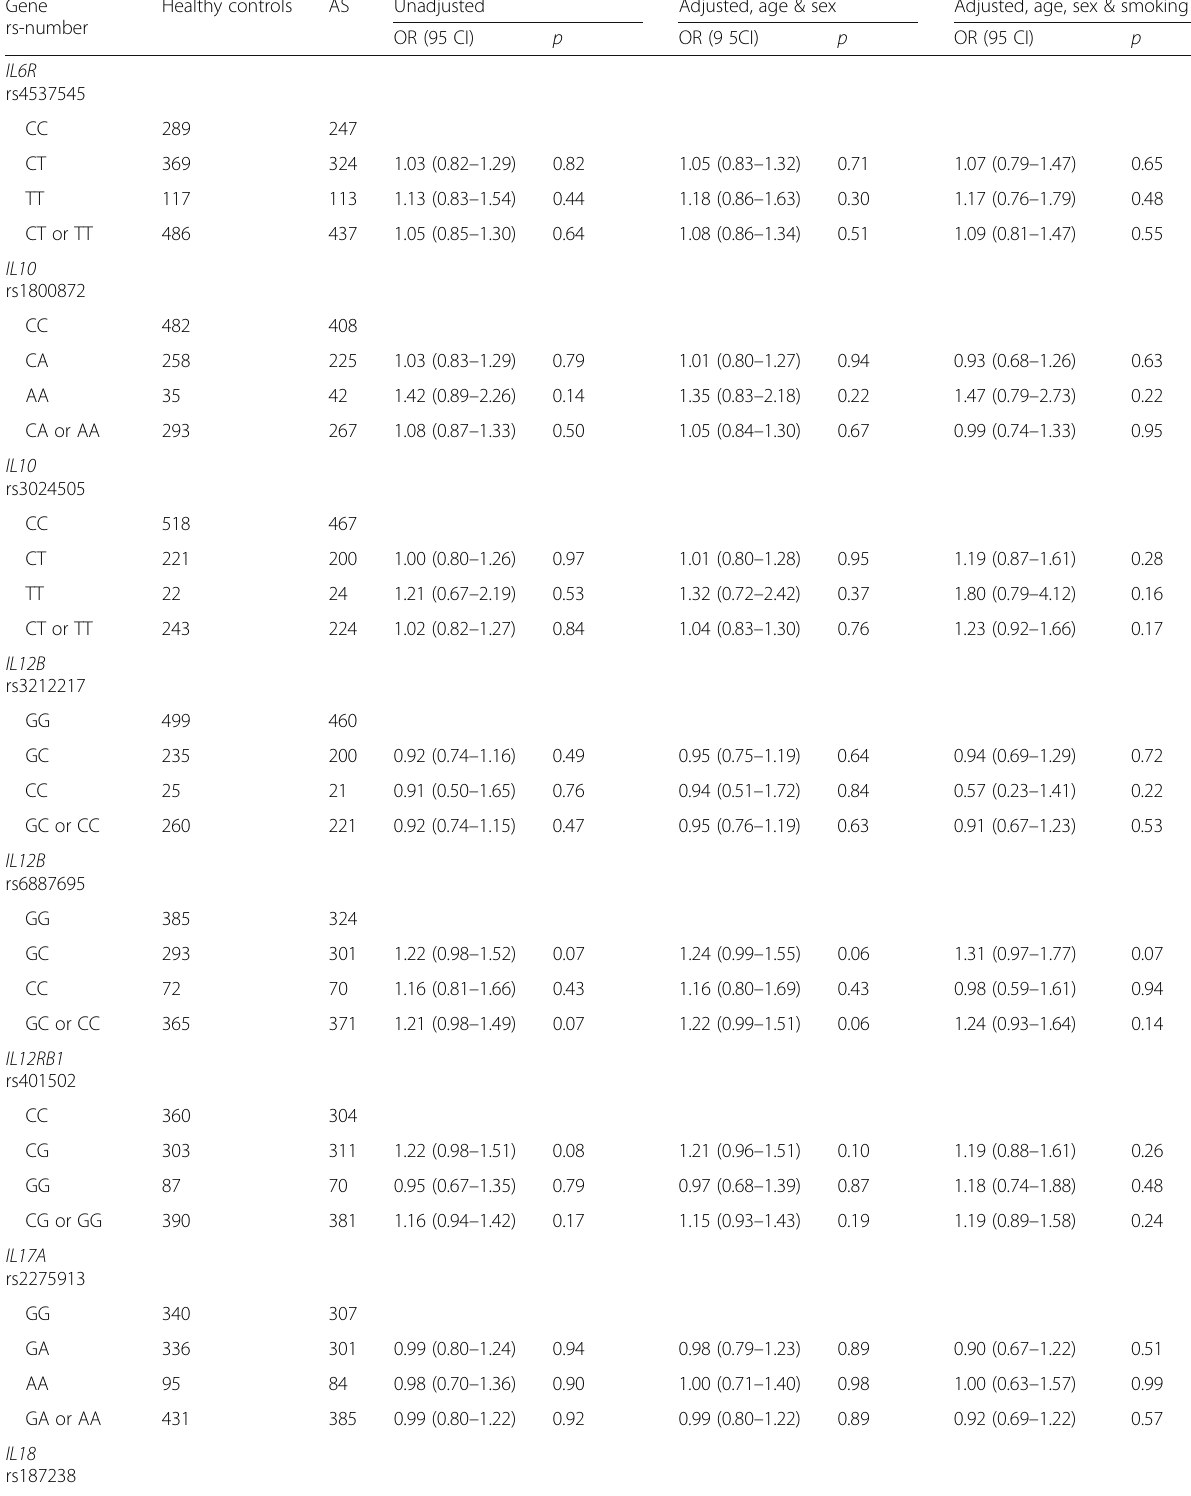
Table 1 Odds ratios (OR) and 95% confidence interval (95CI) for genotypes studied among healthy controls and patients with ankylosing spondylitis (AS)